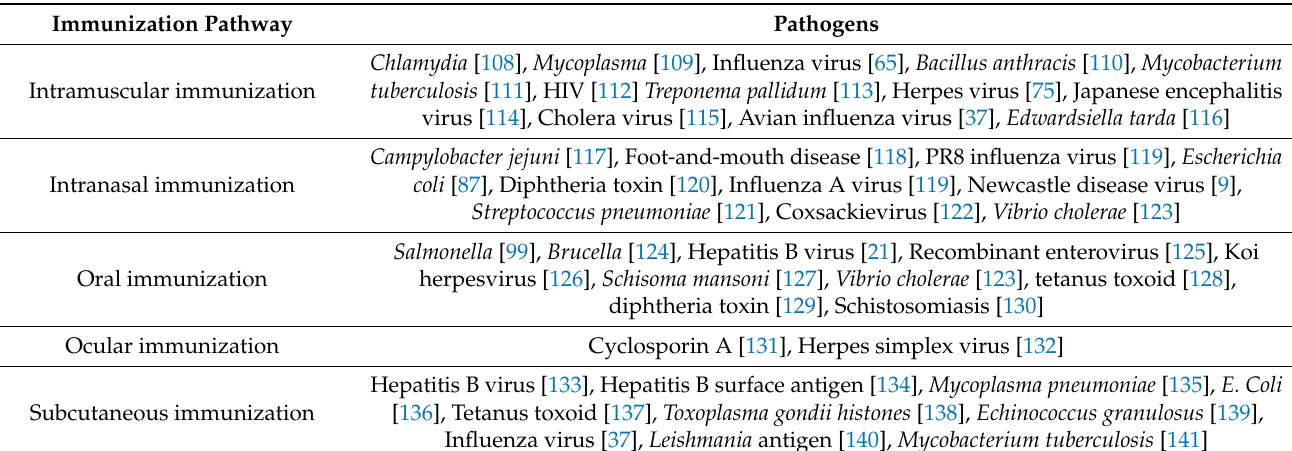
Table 4. A summary of chitosan and its nanocomplexes for pathogen